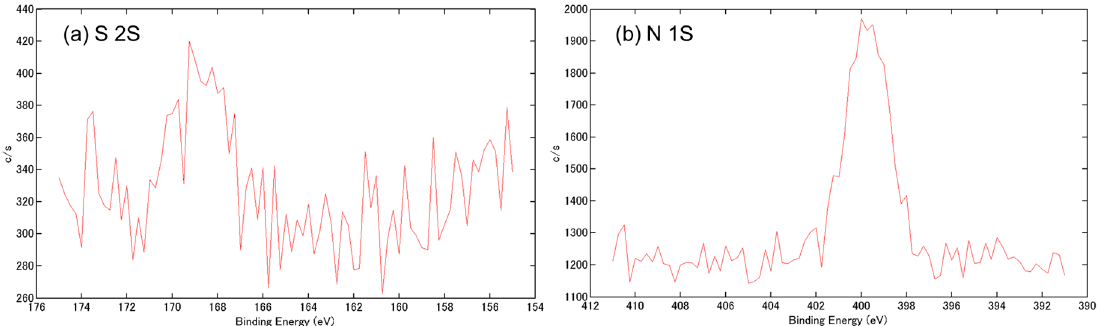
Figure 2. Surface characterization of basic fibroblast growth factor (bFGF) bound to porous α -TCP via heparin. ( a ) X-ray photoelectron spectroscopy (XPS) S 2s and ( b ) XPS N 1s spectra.